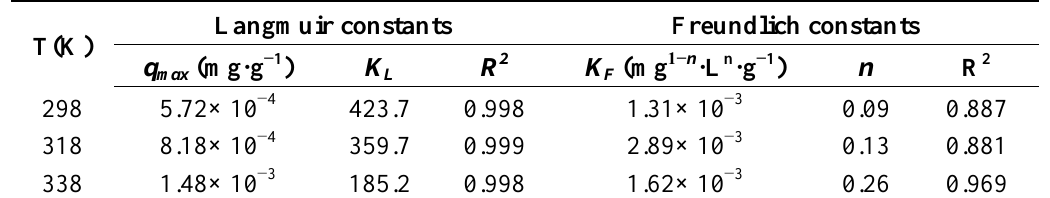
Table 1. The parameters of Langmuir and Freundlich fitting of Th(IV) adsorption on oMWCNTs. Langmuir constants T(K)